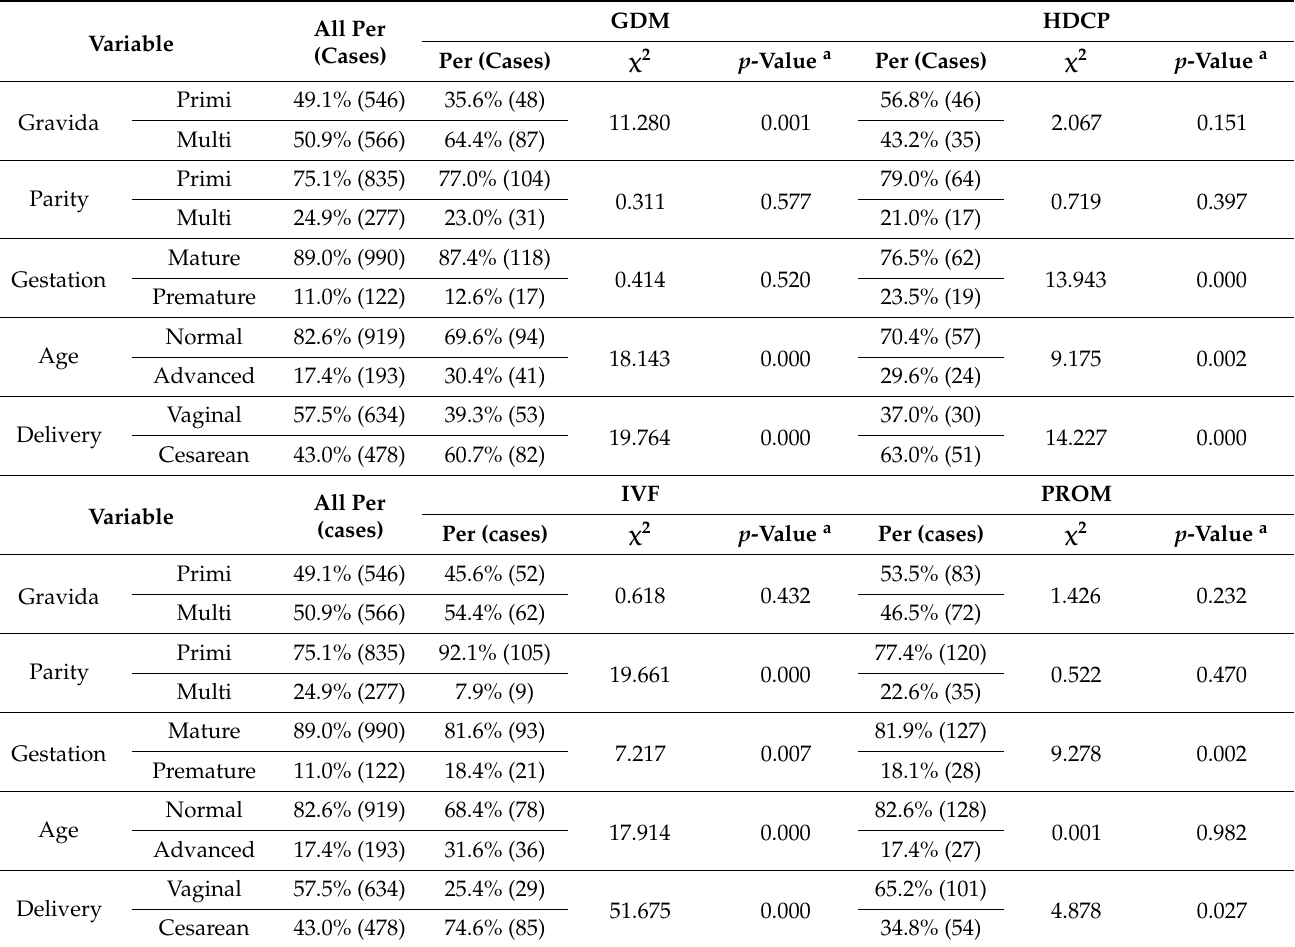
Table 1. Descriptions of clinical features analyzed in this study as related factors with the pregnancy- related diseases of patients with